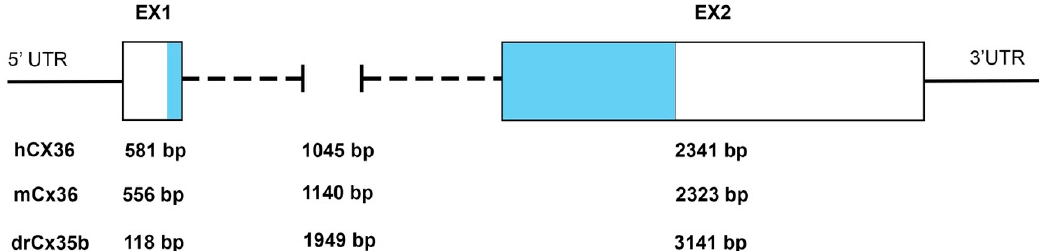
Figure 1. Organization of the exon–intron structure of Cx35/36 orthologs. Examples of the variable length of Cx35/36 exons (Ex) and introns. The relative position of the protein-coding regions is indicated in light blue. Abbreviations: UTR, untranslated region: hCX36/GJD2 , mCx36/Gjd2 , and drCx35b/gjd2b . Data source (ENSEMBL releases GRCh38.p13 (human), GRCm39 (mouse), and GRCz11 (zebrafish)) .